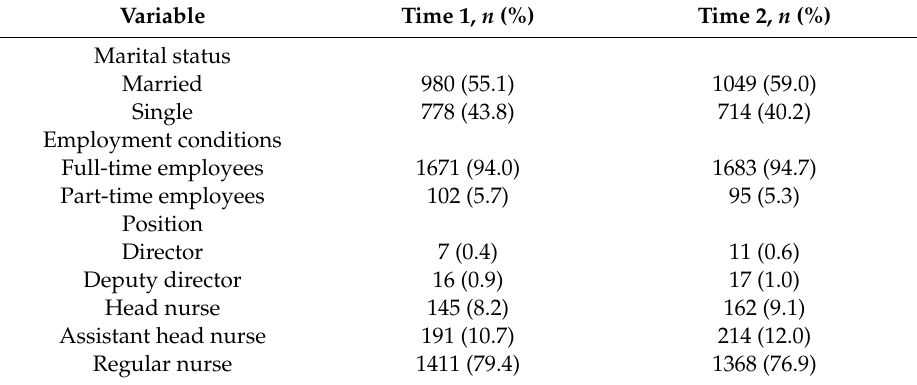
Table 1. Change in participants’ basic attributes between Time 1 and Time 2 ( n =